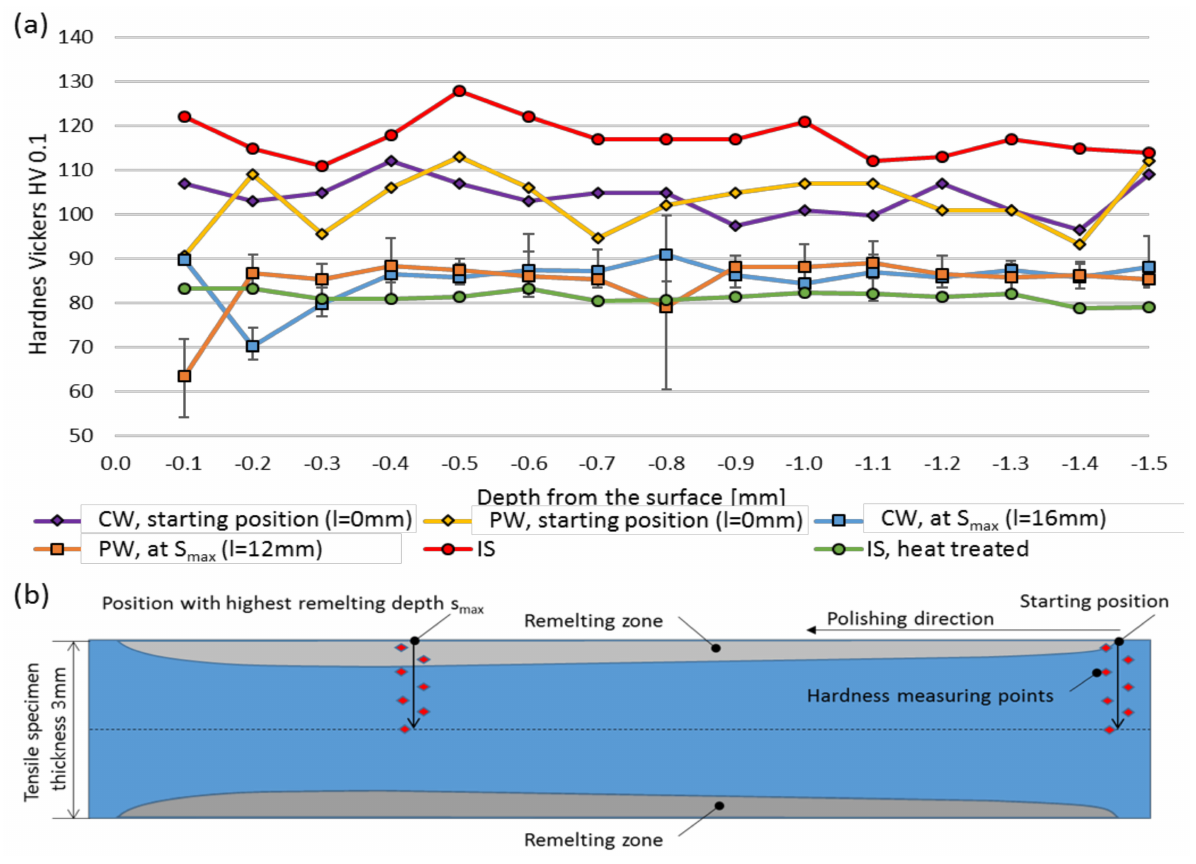
Figure 23. ( a ) Hardness distribution over the thickness of the tensile specimens at the L-PBF state, heat treated state and laser polishing depending at starting position and position with the highest remelting depth s max , ( b ) schematic description of the measuring